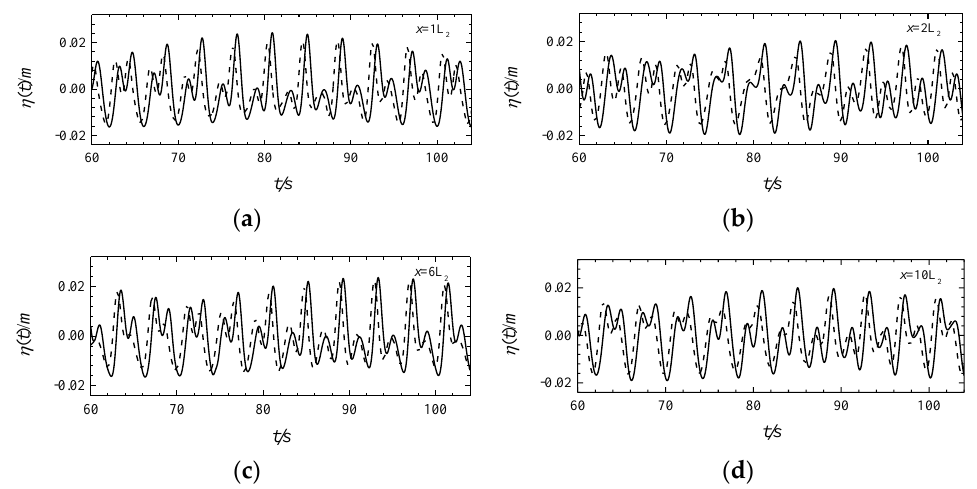
Figure 9. Comparison of wavefronts at X = 1L 2 ( a ), X = 2L 2 ( b ), X = 6L 2 ( c ), X = 10L 2 ( d ) in the MIKE 21 BW model (solid line) and the Navier – Stokes model (dashed line) (operating condition C2).